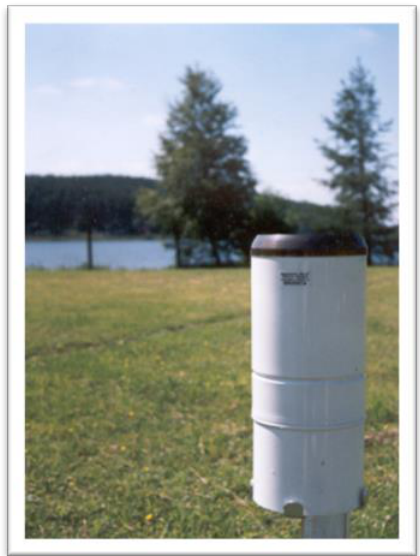
Figure 2. Hellmann rain gauge at the Limnological Station in Borucino.